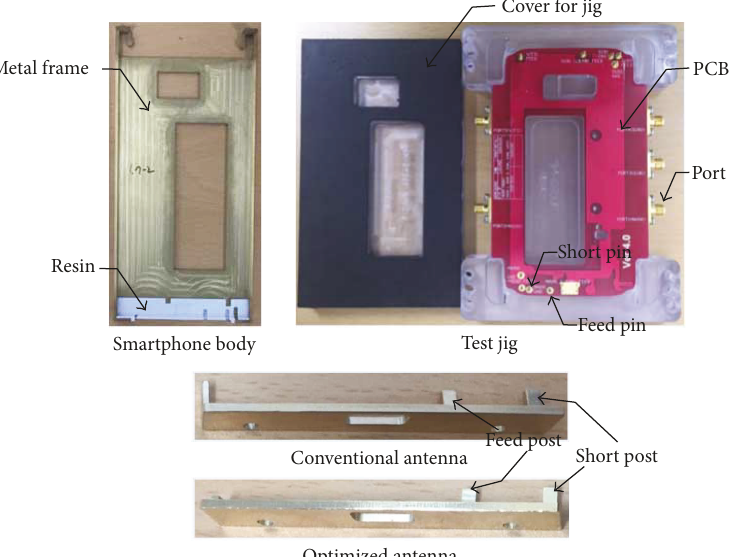
Figure 10: Photograph of the fabricated models and test jig.